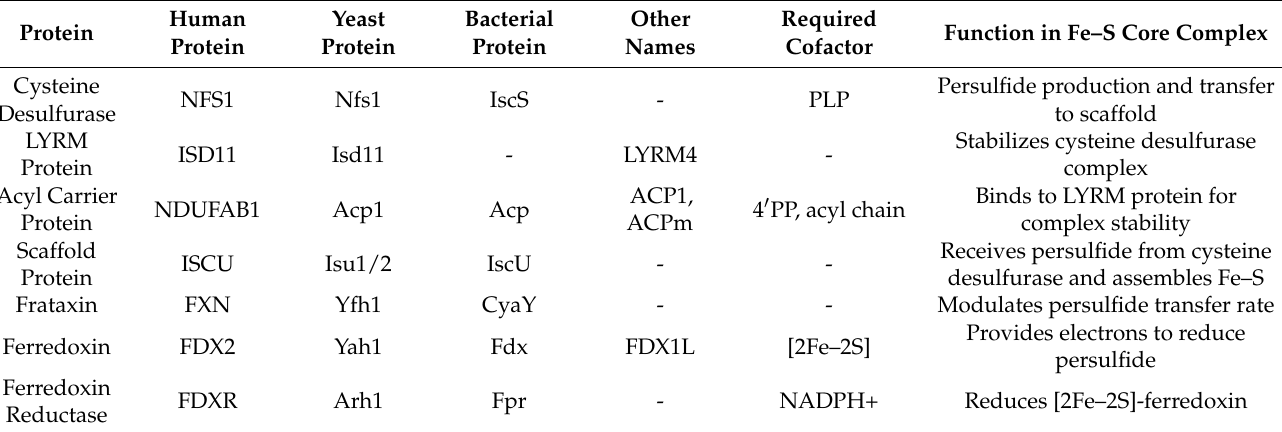
Table 3. List of conserved proteins required for the function of the mitochondrial Fe–S core